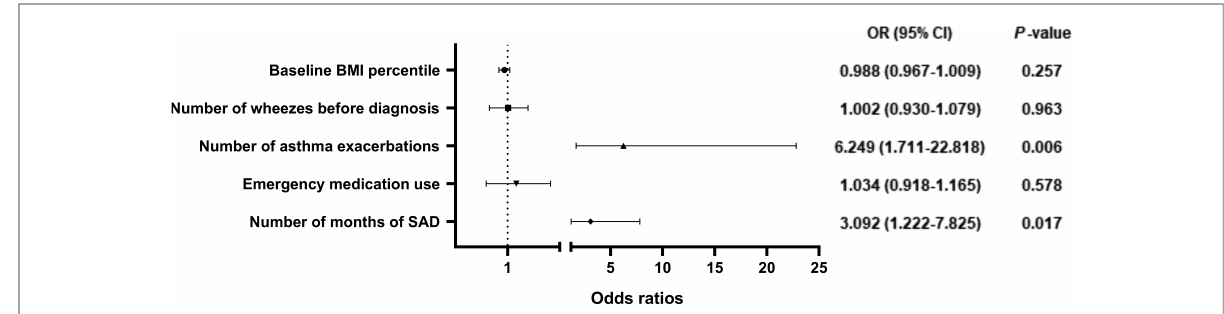
FIGURE 5 Odds ratios for risk factors for poor asthma control after 1 year of anti-asthmatic treatment. BMI, body mass index; SAD, small airway dysfunction